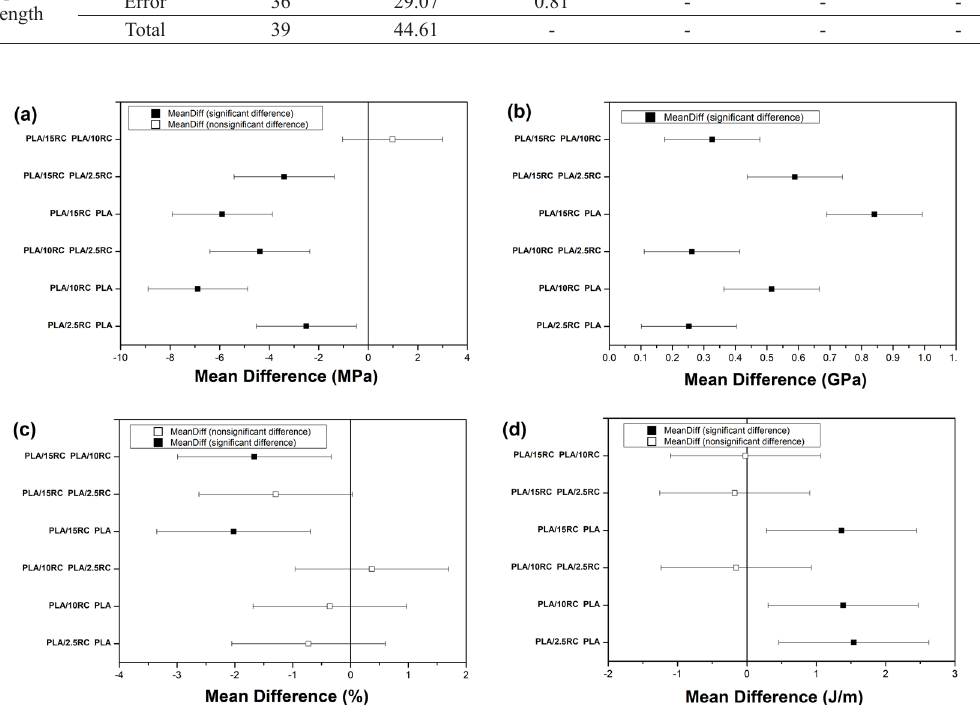
Figure 4. Means Comparison using Tukey Test for: (a) Tensile strength, (b) Young’s Modulus, (c) Elongation at break, (d) Impact